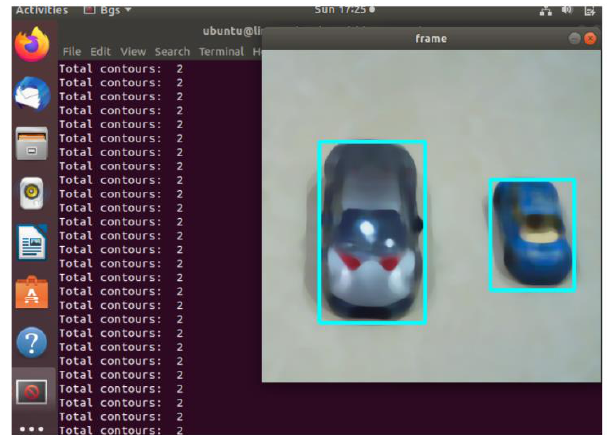
Figure 9a. Lane 1 vehicle density